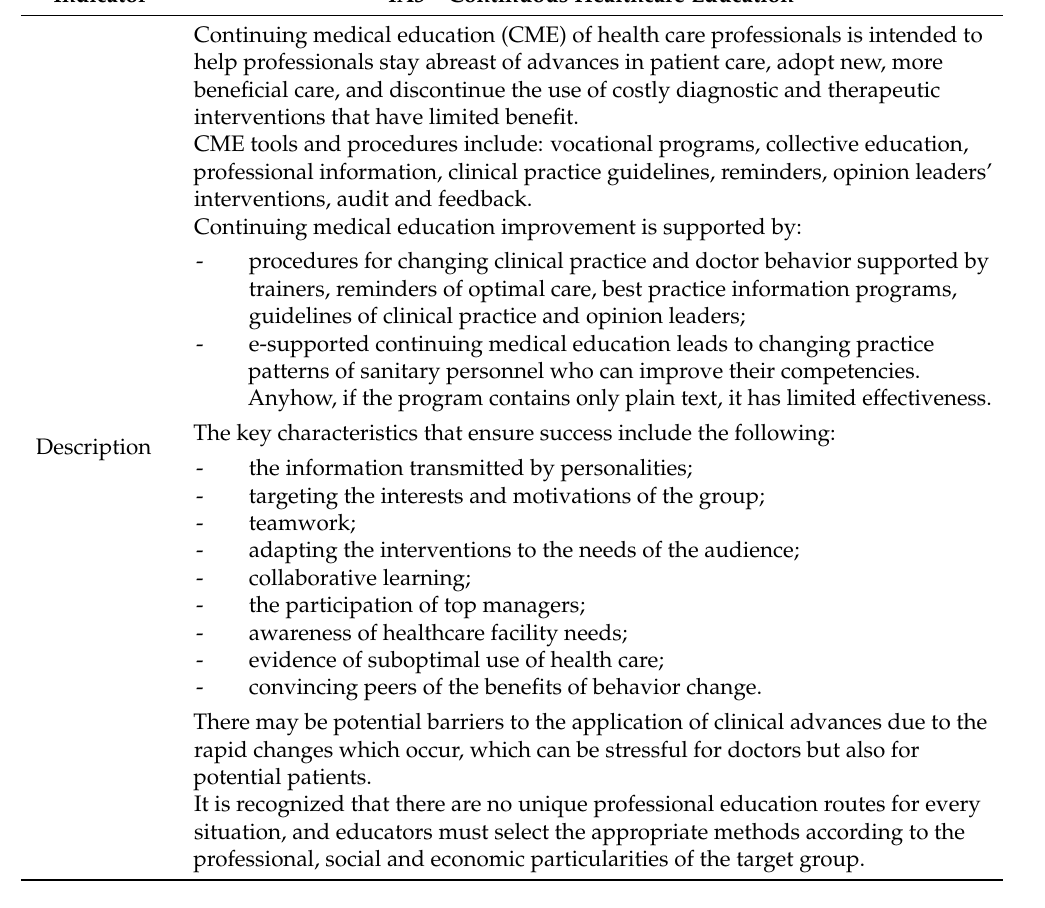
Table A5. The indicator IA31—Continuous healthcare education.